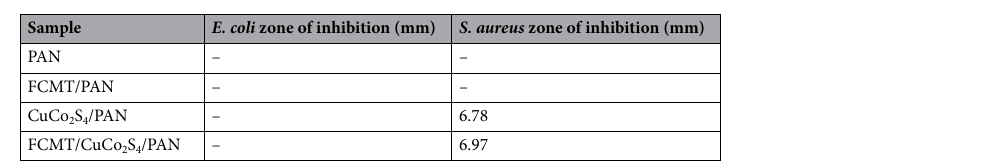
Table 2. Inhibition zone diameters of the